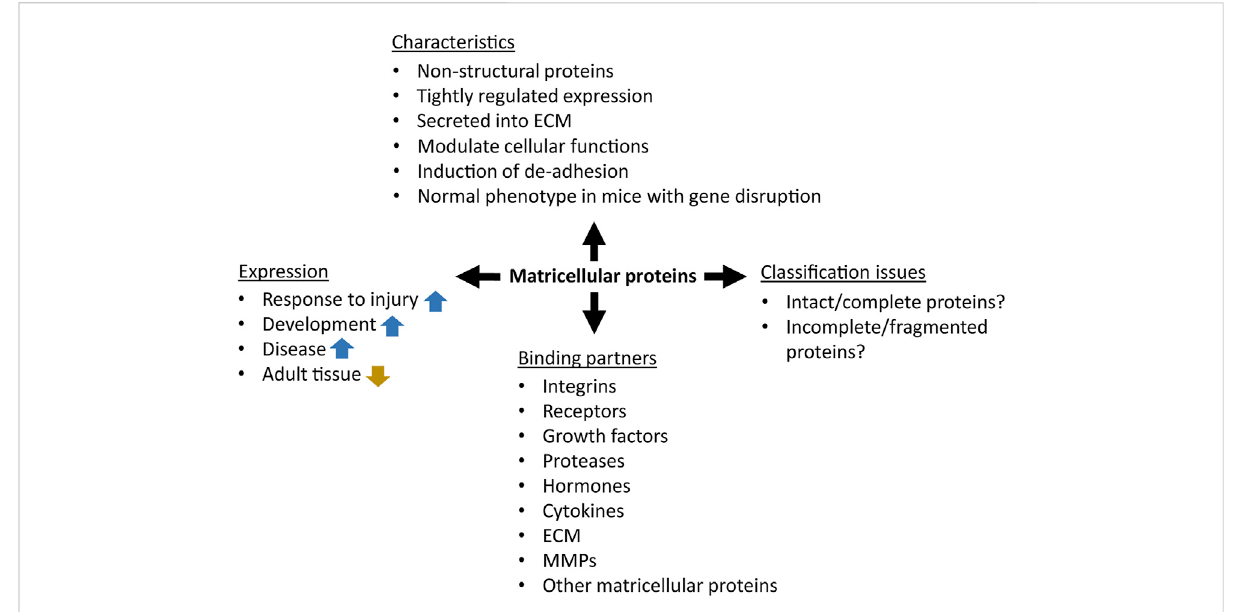
FIGURE 1 The concept of matricellular proteins. The blue and gold arrows represent upregulation and downregulation, respectively.